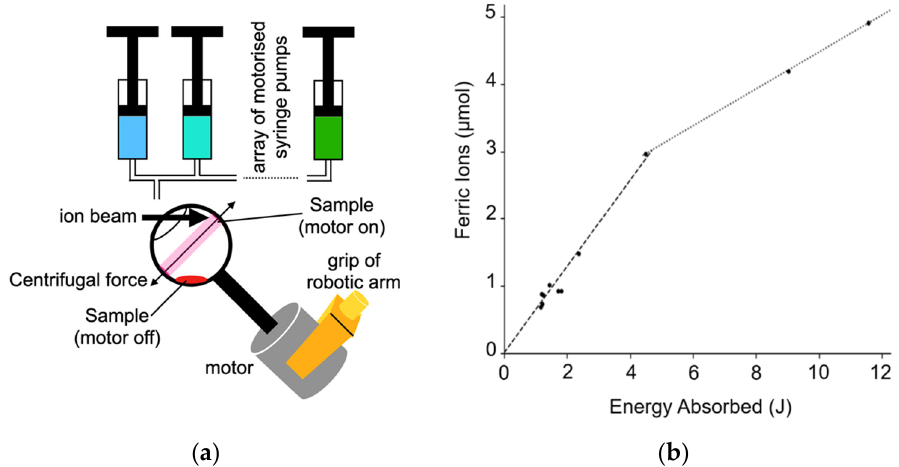
Figure 13. A new sample handing system developed for ion beam experiments. ( a ) Schematic illustration of the spinning wine glass sample holder and syringe pumps configured to support irradiation of thin samples. ( b ) The amount of ferric ions produced by irradiation by 5 MeV protons. The dashed line shows the early high ferric ion production at 0.64 µmolJ − 1 the dotted line showing the later slower production at 0.275 µmolJ − 1 .